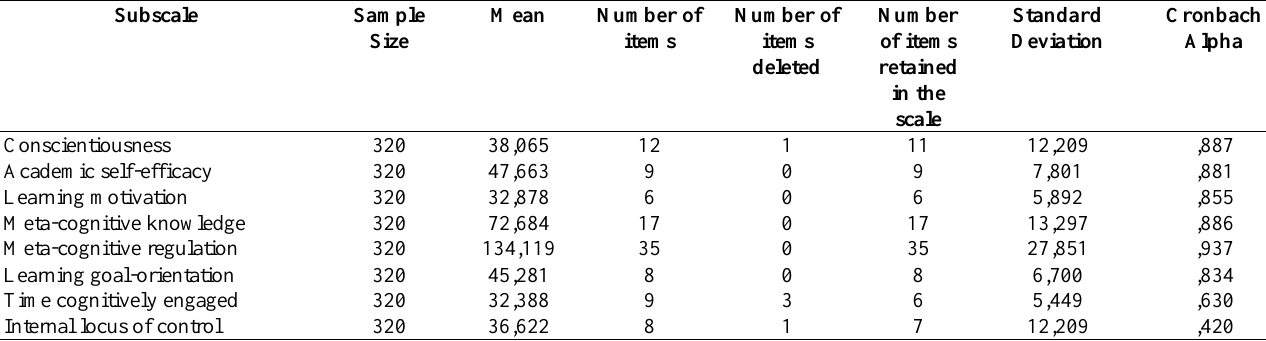
Table 2: Subscale statistics; a summary of results of the item analysis